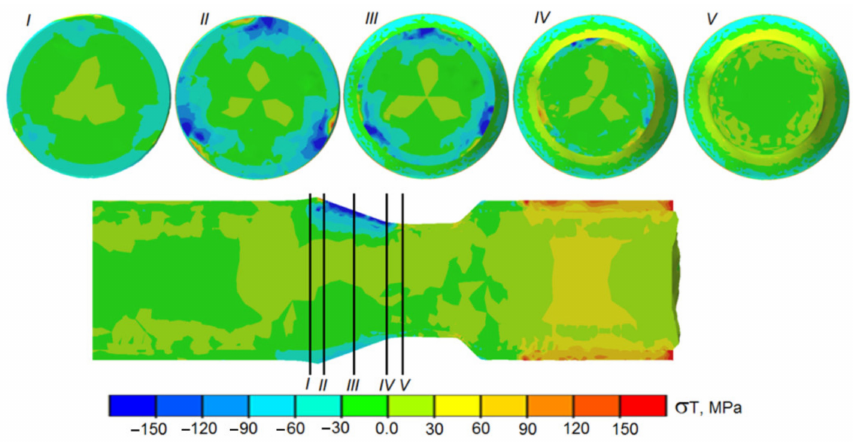
Figure 14. Distribution of circumferential stress in the tool–workpiece contact zone during the rolling of bimetallic rods modeled by